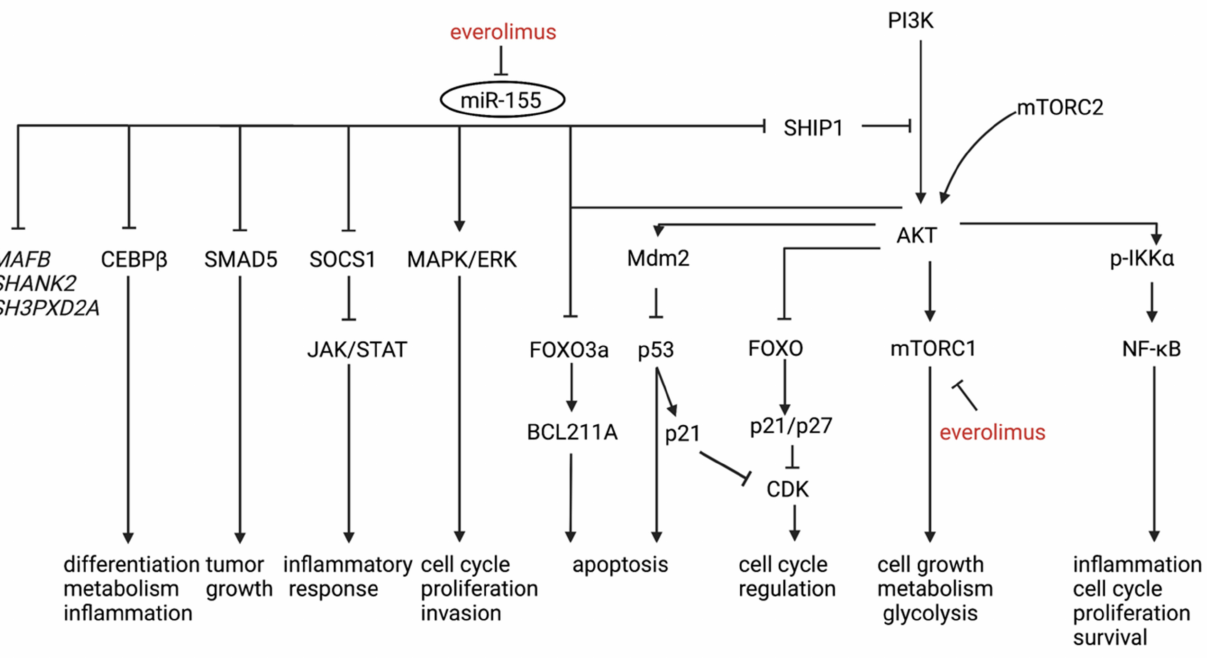
Figure 3. An illustrative overview of the pathways involved with increased miR-155 expression in WM. MAFB, SHANK2 and SH3PXD2A (italic) are more recently discovered targets of miR-155 in WM and further studies are needed to elucidate their role. Everolimus-dependent anti-WM activity is partially driven by targeting miR-155